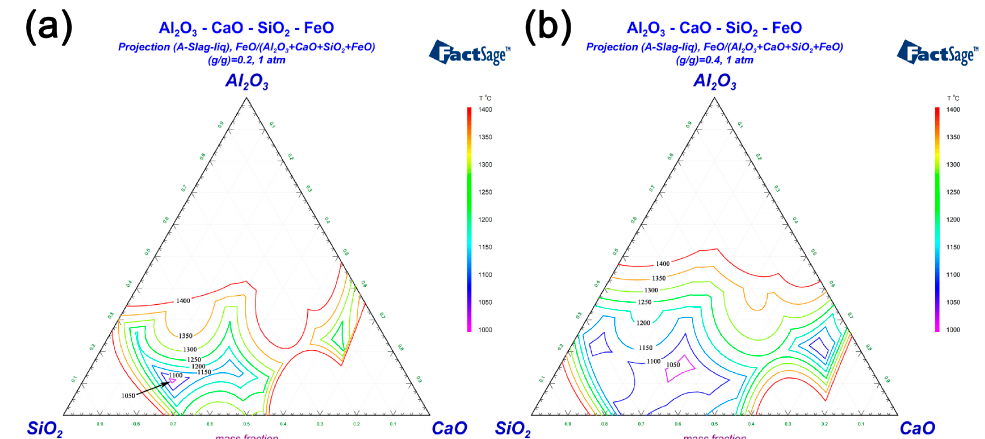
Figure 9. Effects on liquid areas of Al 2 O 3 -SiO 2 -CaO-FeO phase diagrams by FeO of: ( a ) FeO/(Al 2 O 3 - SiO 2 -CaO-FeO) (g / g) = 0.2; ( b ) FeO / (Al 2 O 3 -SiO 2 -CaO-FeO) (g / g) = SiO 2 -CaO-FeO) (g/g) = 0.2; ( b ) FeO/(Al 2 O 3 -SiO 2 -CaO-FeO) (g/g) = 0.4.